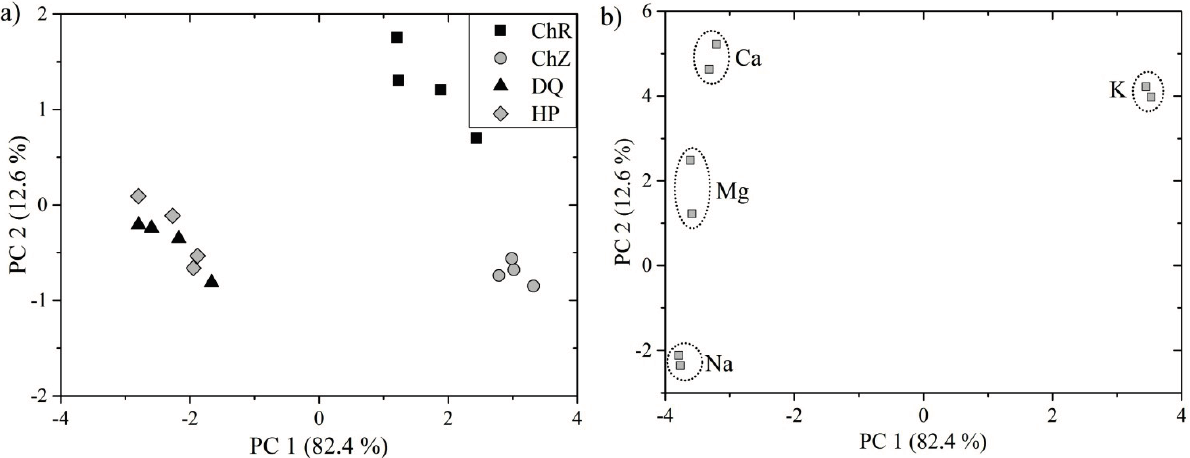
Figure 4. PCA of four algal strains based on their LIBS measurement: ( a ) scores; ( b )